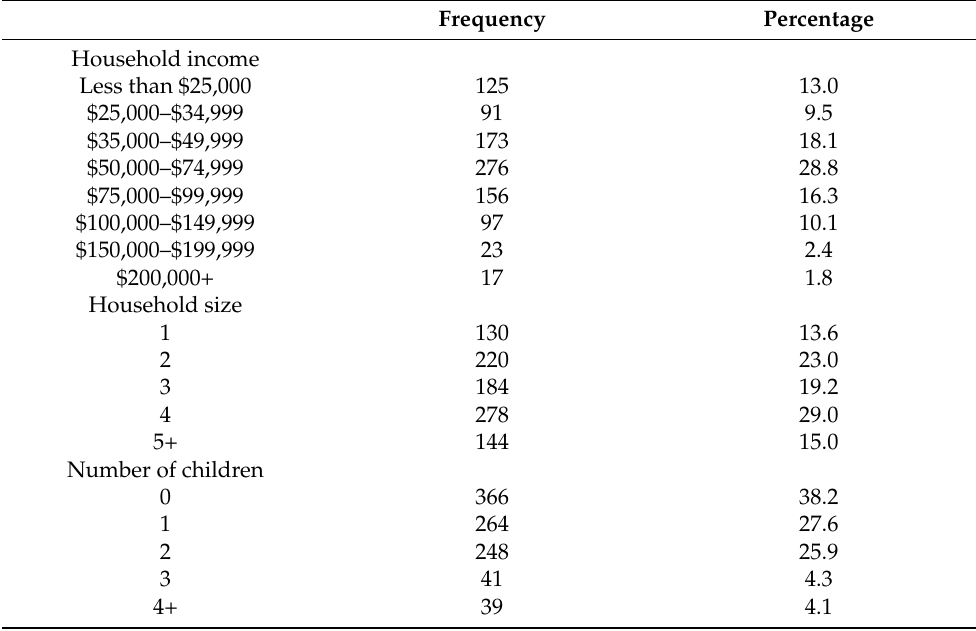
Table 2. Household characteristics of US adults who completed the COVID-19 and Lifestyle Ques- tionnaire ( n =